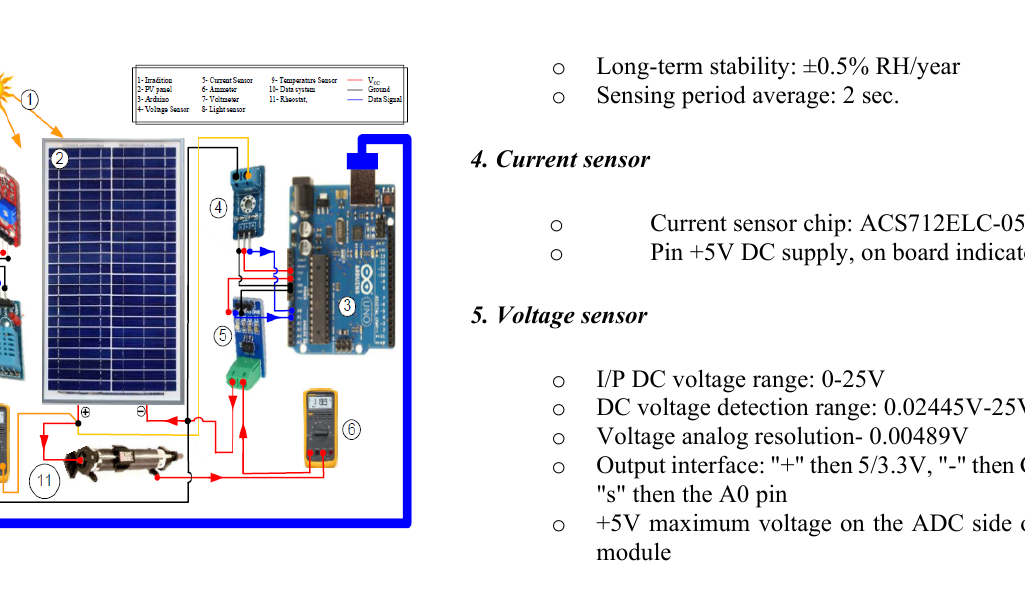
Figure 1. Schematic diagram of system under consideration